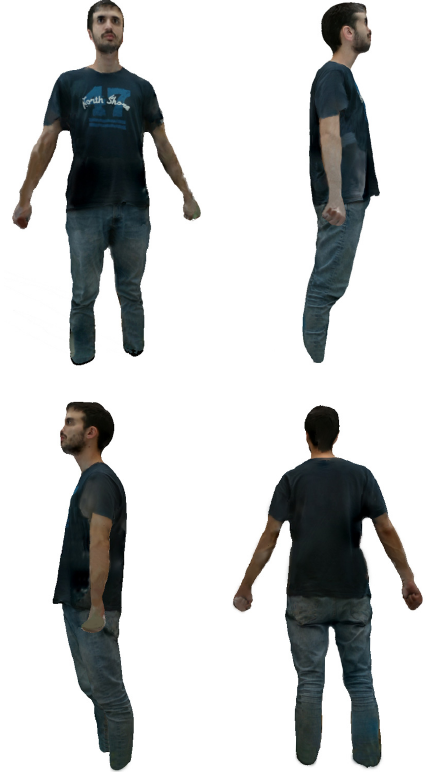
Figure 11. Di ff erent views of the same textured body Figure 11. Different views of the same textured body model.